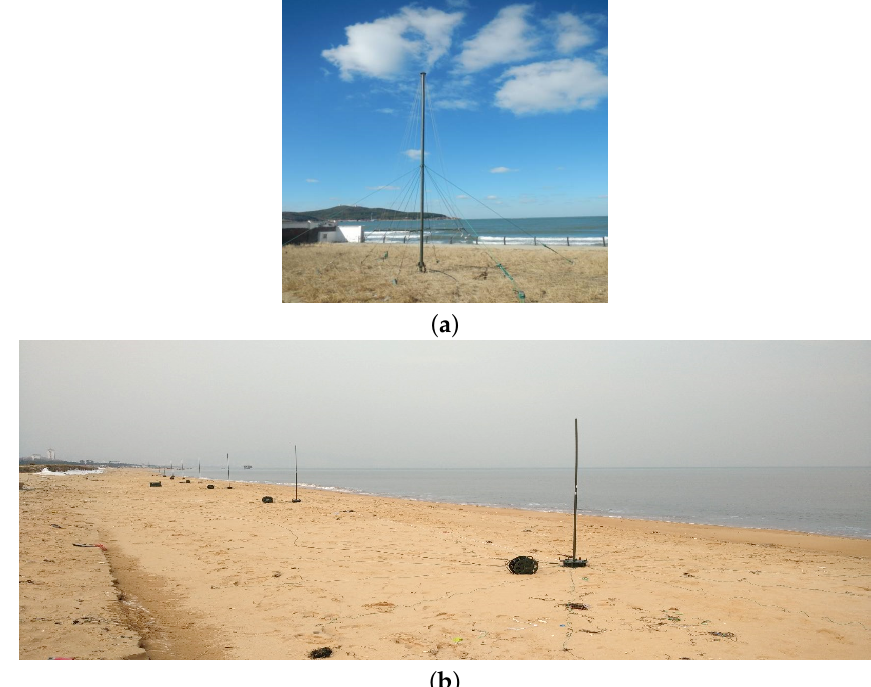
Figure 2. Transmitting antenna and one receiving antenna array of the developed T/R-R compact HFSWR system. ( a ) Transmitting antenna installed at Weihai radar station. ( b ) One receiving antenna